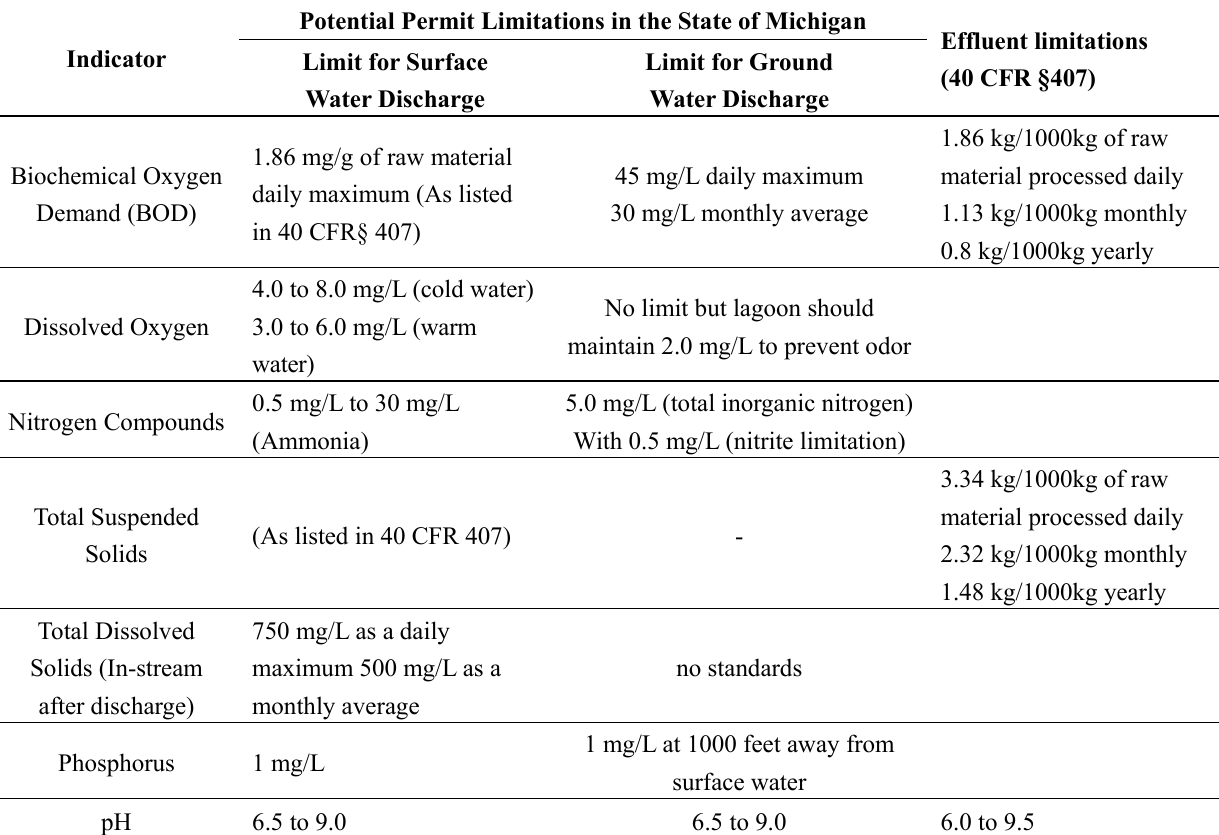
Table 1. Potential Permit Limitations in the State of Michigan for effluent discharge into surface and ground water (Source: Granholm and Chester, [6]) and effluent limitations for BOD and Total Suspended Solids (TSS) (kg/1000kg of raw material processed) and for pH as listed in 40 CFR